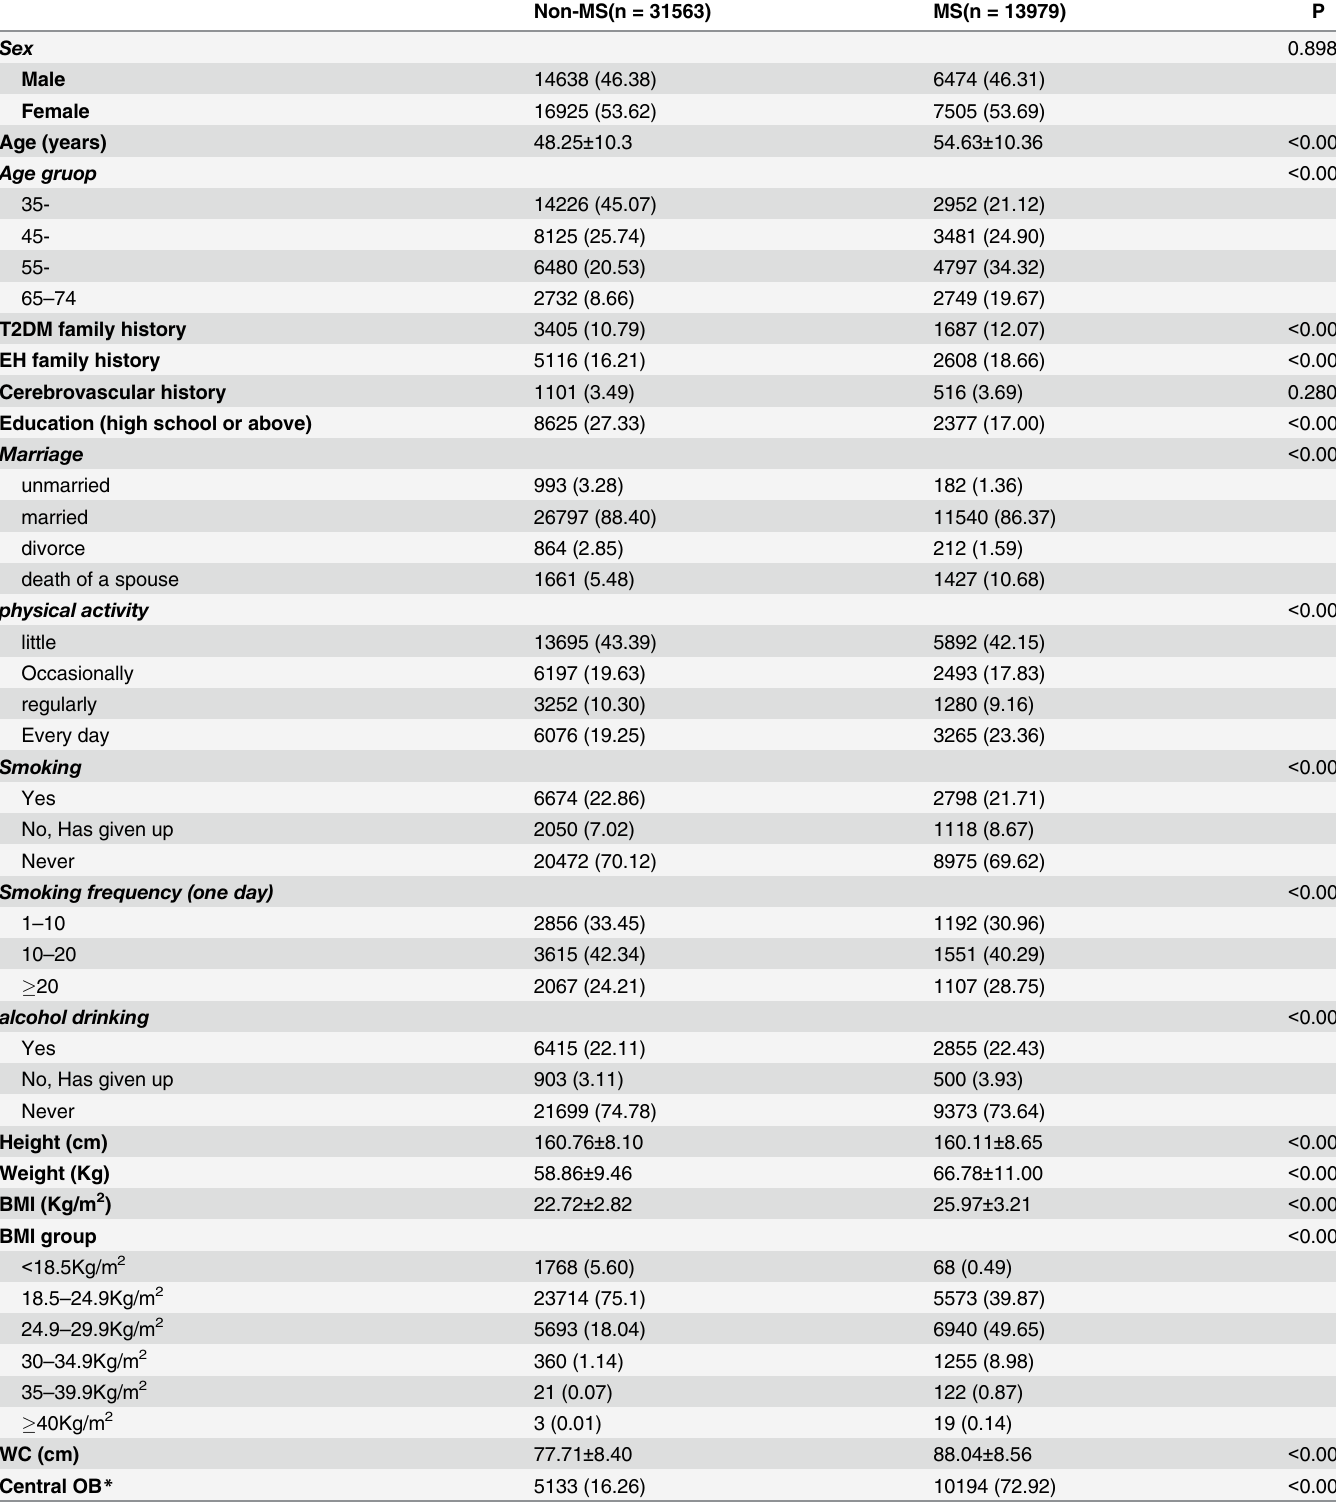
Table 1. Baseline Characteristics(N =